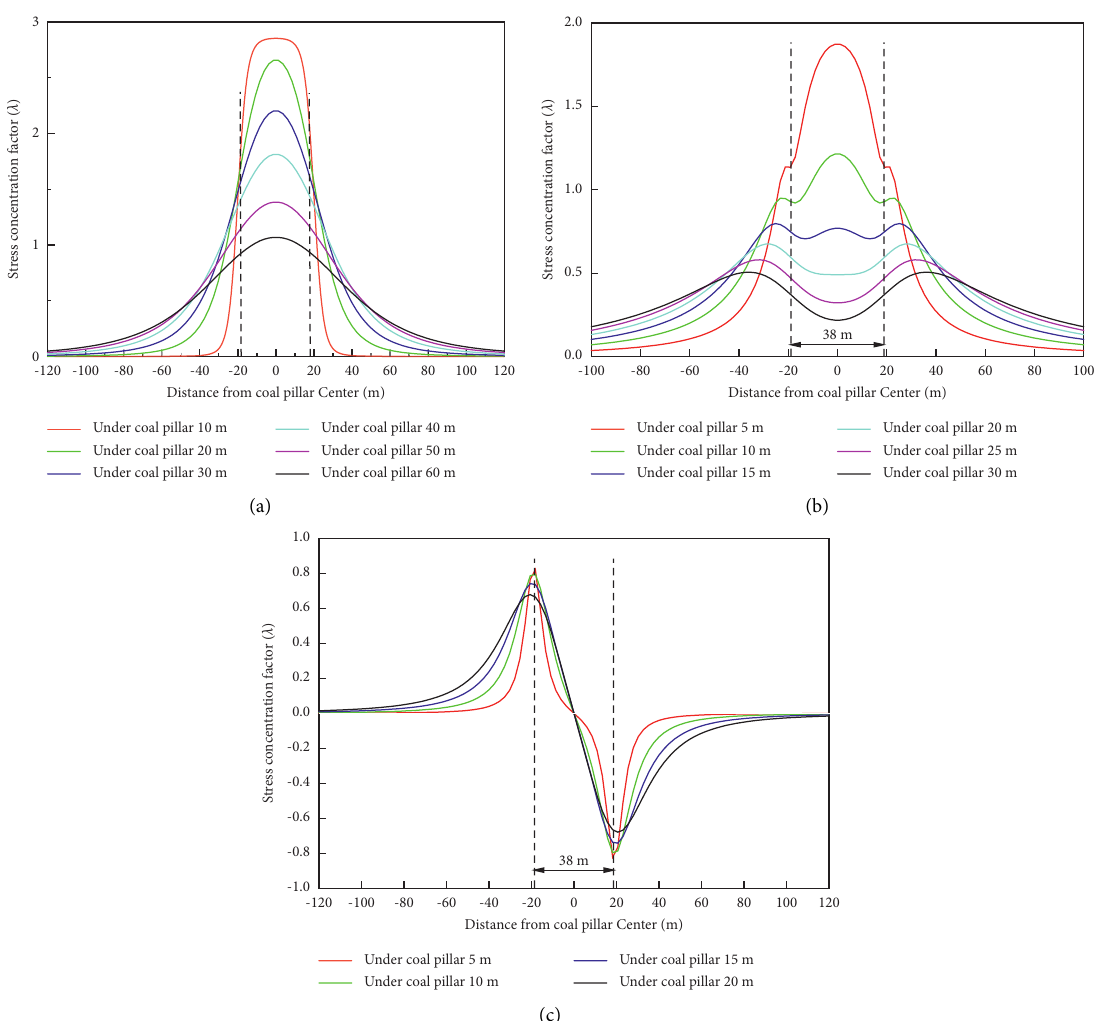
Figure 7: Stress distributions of the residual coal pillar floor at different depths. (a) Vertical stress. (b) Horizontal stress. (c) Shear